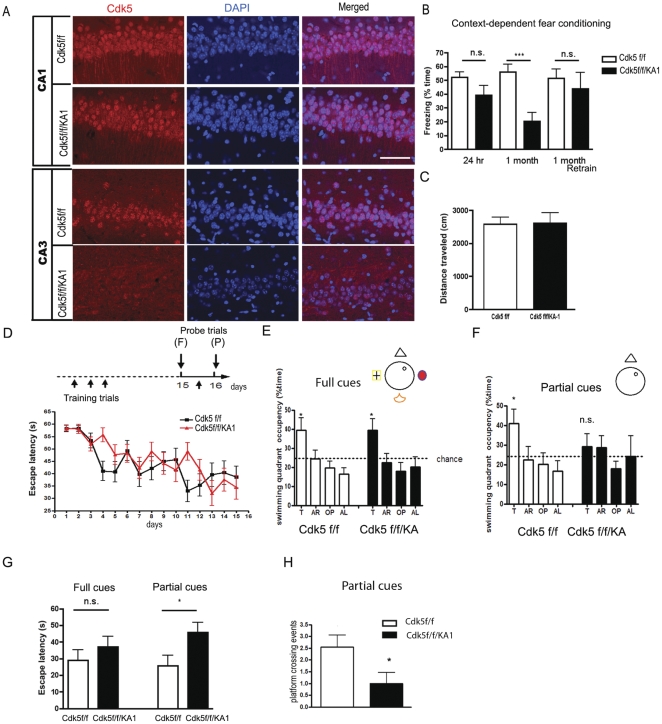
Memory retrieval is impaired in Cdk5f/f/KA1 mice.
A. Immunostaining for Cdk5 in hippocampal areas CA1 and CA3 in Cdk5f/f and Cdk5f/f/KA1 mice. Scale bar, 100 µm. B. Contextual-dependent fear conditioning test for Cdk5f/f/KA1 mice. Cdk5f/f, n = 10; Cdk5f/f/KA1, n = 8. C. Distance traveled during the initial 3 min exposure to the training box. D. Morris water maze training paradigm (top). Mice were trained for 16 days. On day 15, they were tested in a probe trial with full visual cues around the tank, followed by an additional training trial. On day 16, mice were tested in another probe trial with most of the visual cues removed around the tank. (Bottom) Latencies for the mice to reach the platform during training did not show significant differences between Cdk5f/f/KA1 (n = 10) and Cdk5f/f mice (n = 10). (P), partial cues, (F), full cues. E. Cdk5f/f/KA1 mice showed similar preferences toward the target quadrant as the Cdk5f/f group in a full cue trial on day 15. F. Cdk5f/f/KA1 mice did not show preferences toward the target quadrant in the partial-cue-trial on day 16. G. Cdk5f/f/KA1 mice take more time to reach the hidden platform position than Cdk5f/f mice in the partial cue, but not the full cue, trial. H. In the probe trial with partial cues, the average number of crossings over the platform position is much lower for the Cdk5f/f/KA1 group than that for the Cdk5f/f group. *p<0.05; **p<0.005.